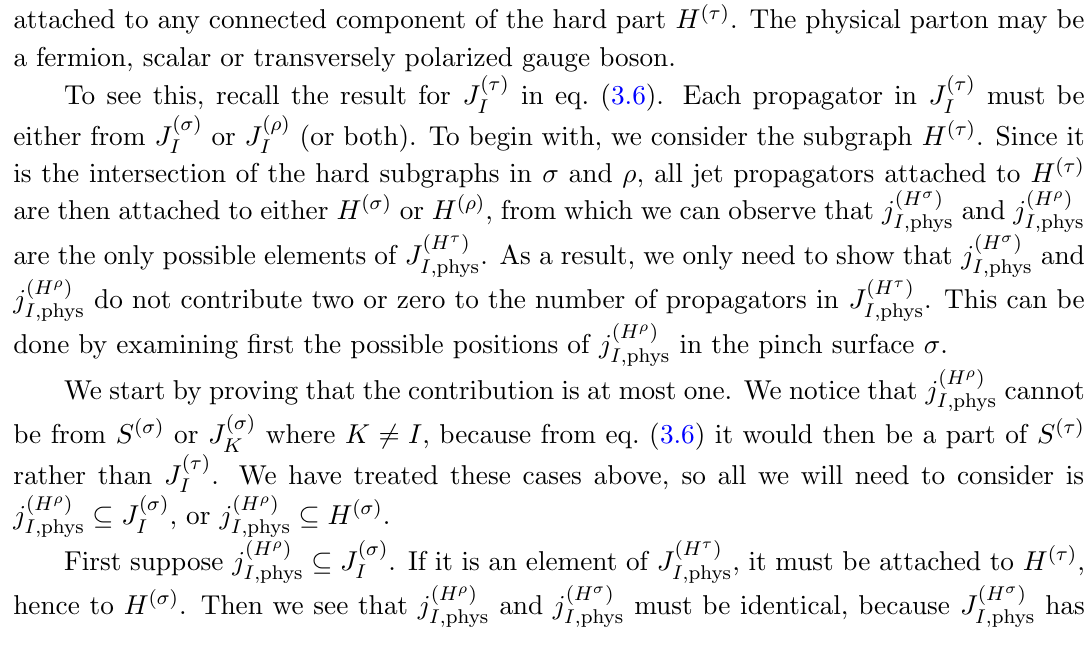
the vertex a is not included in H ( (cid:26) ) (enclosed by the dashed curve) in (cid:26) . The